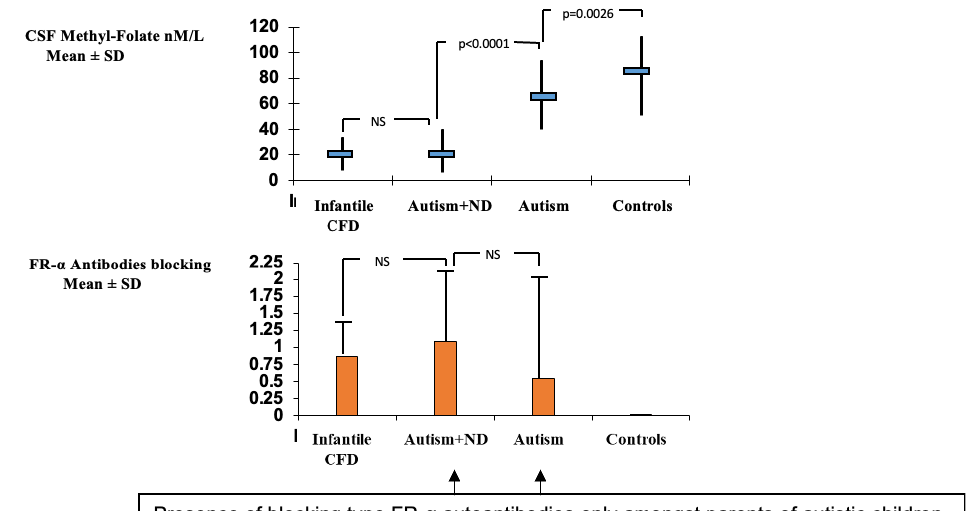
Figure 3. Comparison of CSF methyl-folate levels and FR α autoantibodies in infantile CFD, autism with neurologic deficits (Autism + ND), infantile autism and healthy